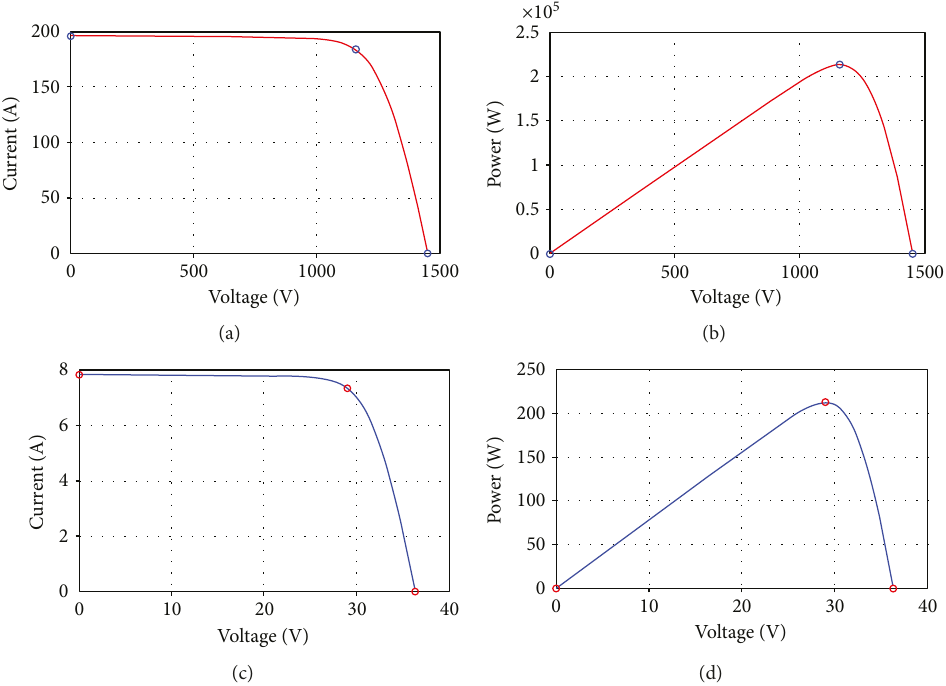
Figure 7: (a) Total PVSES output V-I diagram, (b) total PVSES output V-P diagram, (c) a photovoltaic solar panel V-I diagram, (d) a photovoltaic solar panel V-P